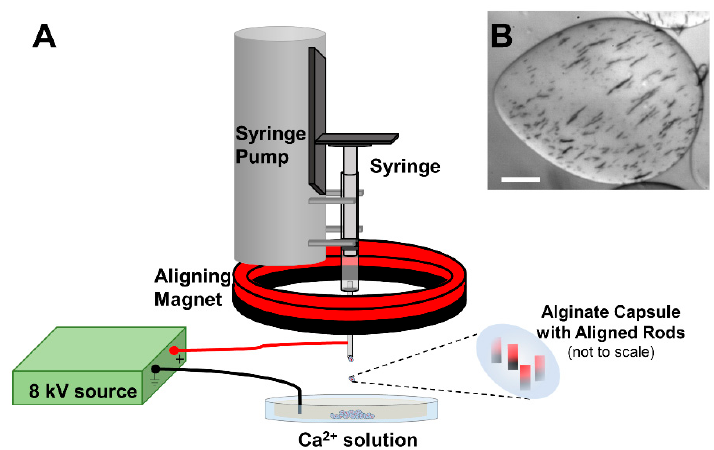
Figure 1. MANiAC synthesis. ( A ) A syringe pump pushes the mixture of magnetic nanorods and alginate through an aligning magnet prior to reaching the blunted needle tip. A high voltage source supplies ~8 kV between the Ca 2+ solution and the syringe generates a dropwise extraction of capsules embedded with aligned nanorods. ( B ) Optical image of aligned nanorods in alginate capsule. Scale bar = 100 µm.